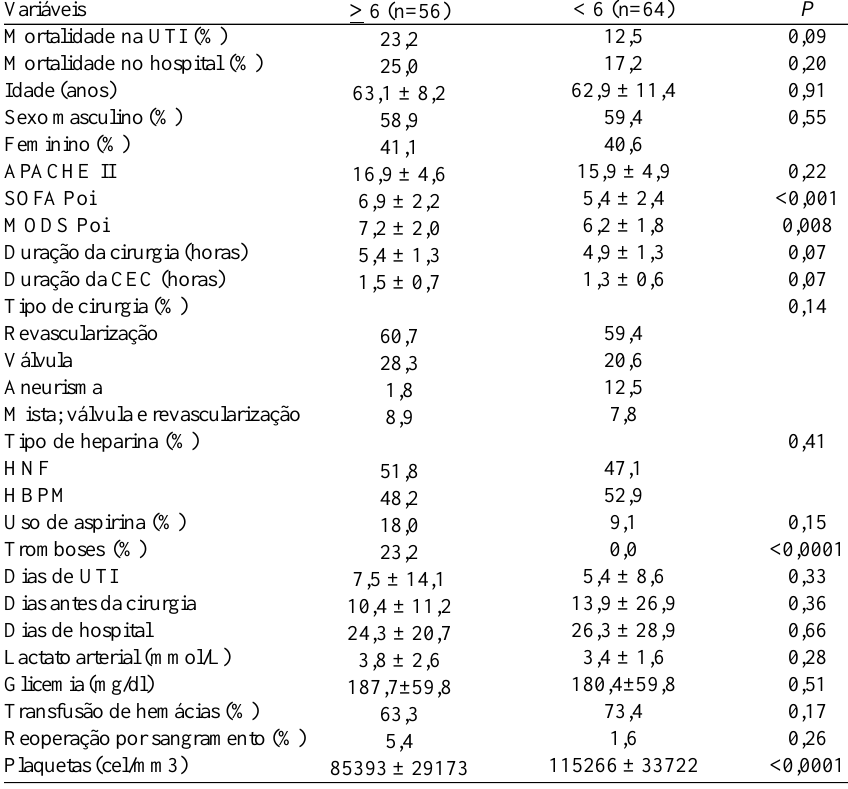
HNF - heparina não fracionada; HBPM - heparina de baixo peso molecular; Tromboses - acidente vascular cerebral isquêmico, infarto agudo do miocárdio, trombose venosa profunda,